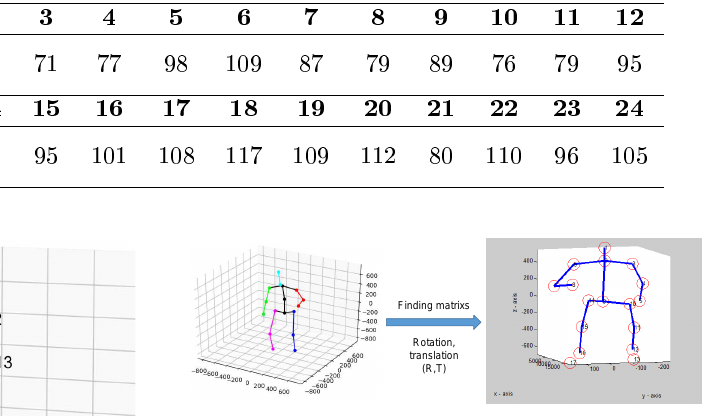
Fig. 11: Illustration of (cid:28)nding the rotation, translation matrix in the 3-D space.